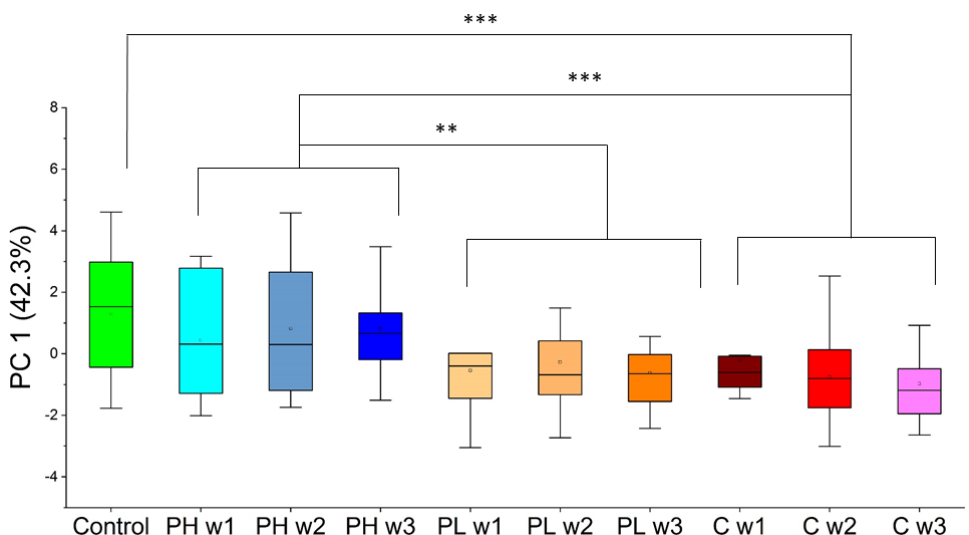
Figure 3. PC 1 scores in one dimension using the VOCs highlighted through approach 1 for all sam- ple classes of interest (PH = pitavastatin high, PL = pitavastatin low, C = cancer). ** p- value < 0.01, *** p -value < 0.001. *** p -value <